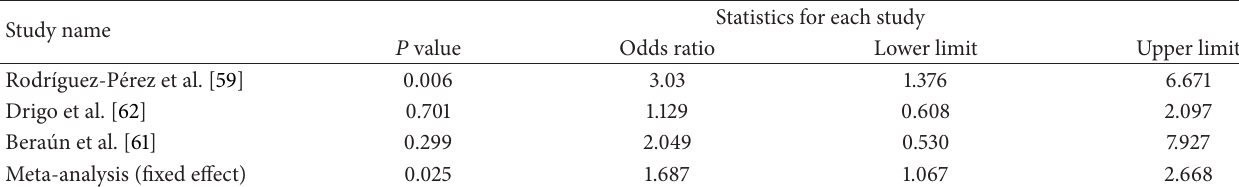
Table 2: Meta-analysis on the TNFA -308